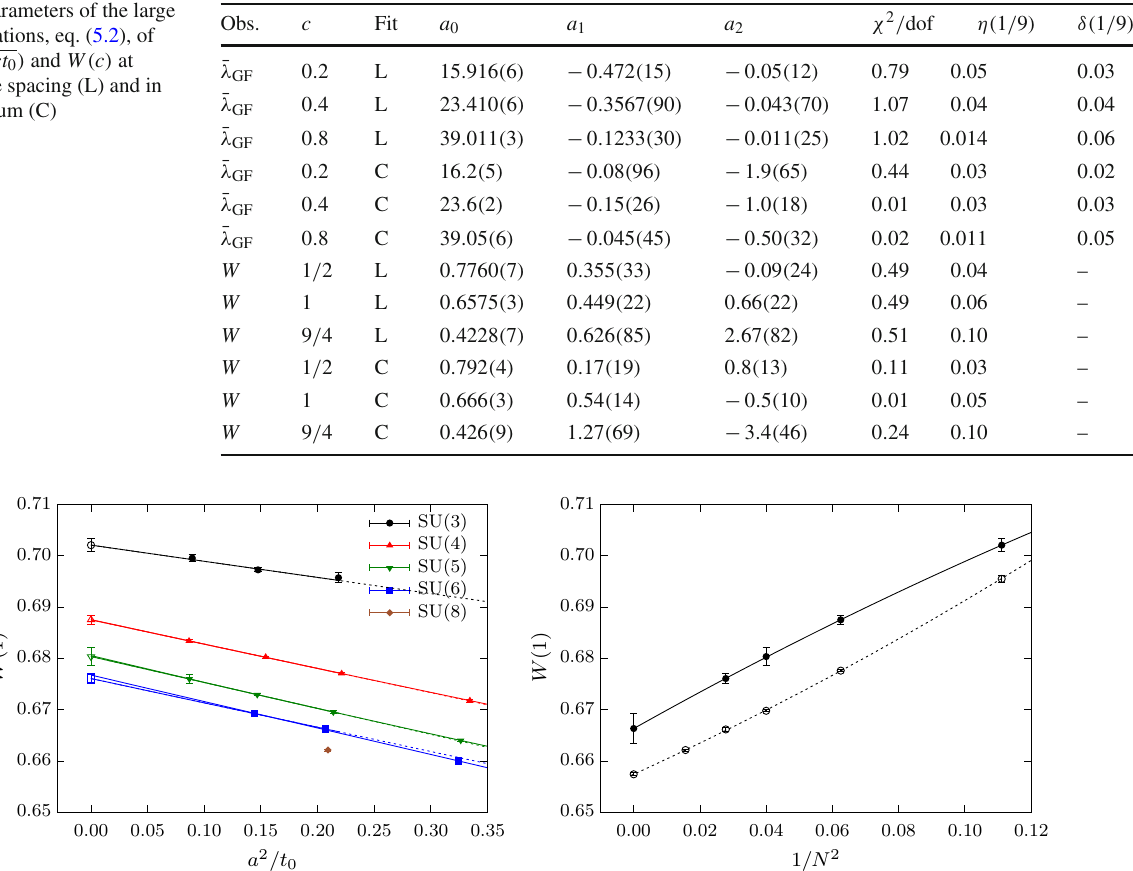
ment between the data and the expected scaling in powers of 1 / N 2